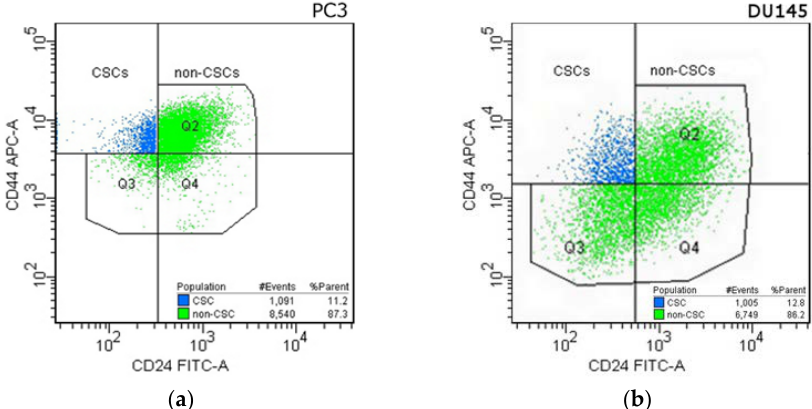
Figure 3. Cytometric analysis of Cancer Stem Cells in: PC3 ( a ) and DU145 ( b ) prostate cancer cell lines. Cells were incubated with anti-CD24 FITC-labeled and anti-CD44 APC-labeled antibodies. CD44+/CD24 − population marked as blue (CSCs), the CD44+/CD24 − depleted population marked as green (non-CSCs). Gates were established based on the appropriate isotype controls.